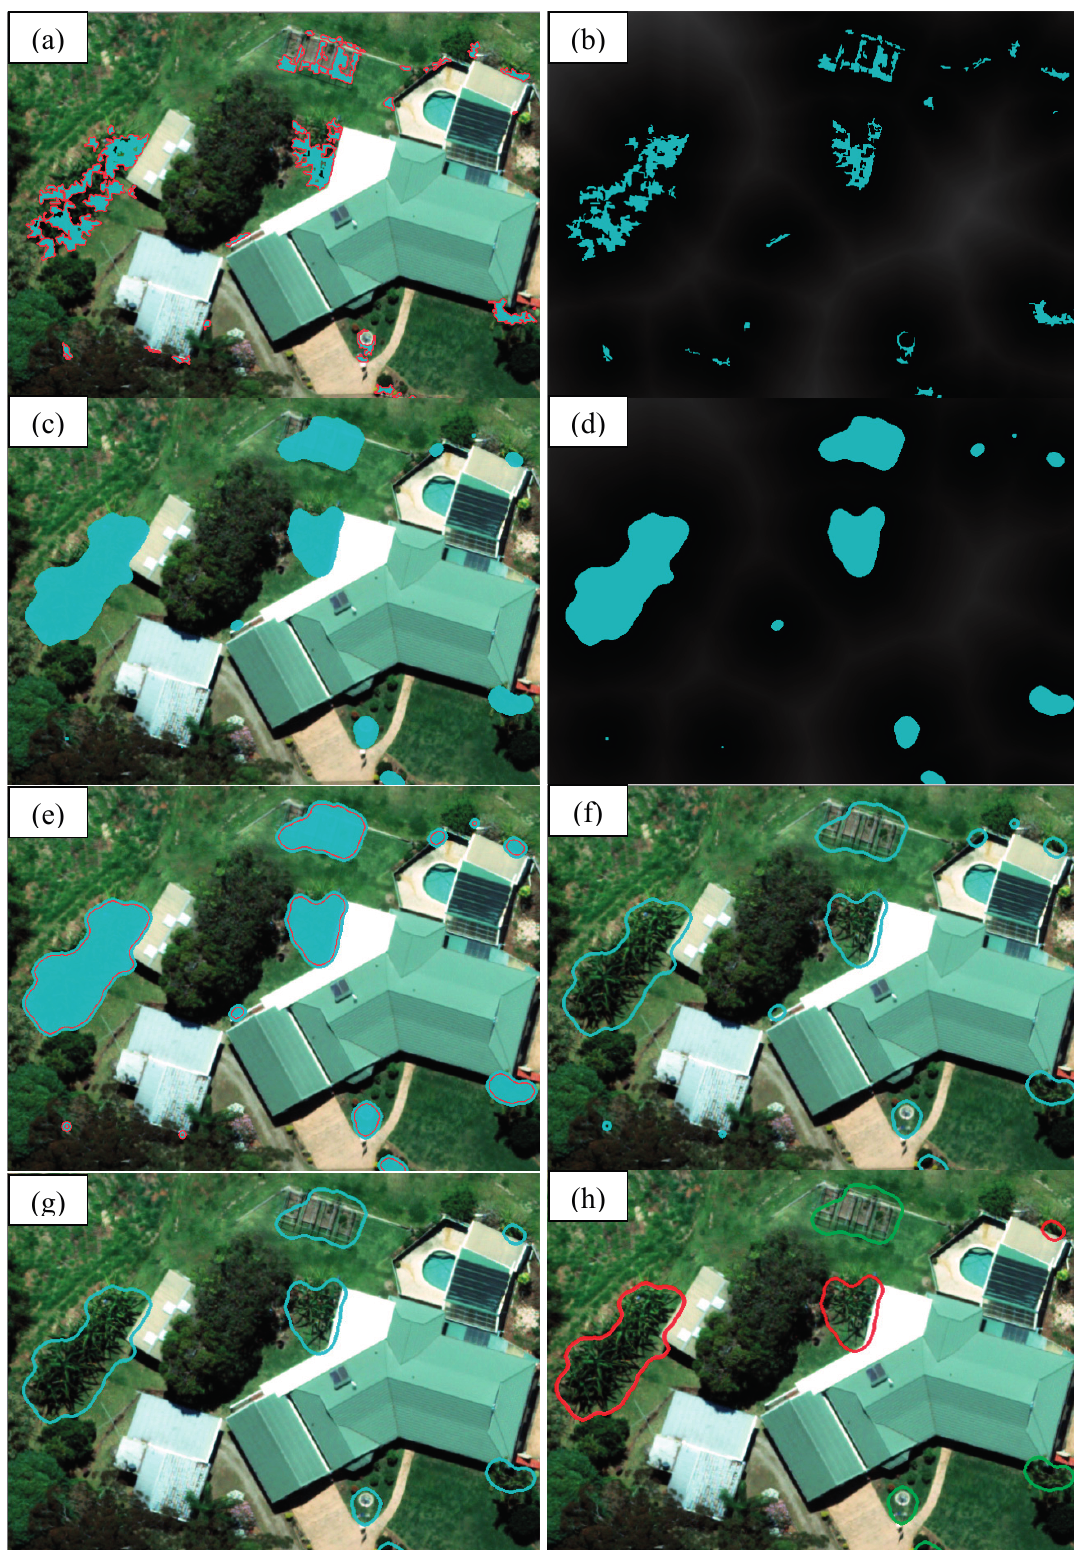
Figure 8. ( a ) Banana plant classification result; ( b ) distance map; ( c ) smoothed banana plant objects; d ) distance map; ( e ) buffer around the smoothed banana plant objects; ( f , g ) remaining buffers, and ( h ) final classification result after the visual assessment (red outlines = banana plants, green outlines = excluded false positives). Location: 153°02 ′ 00 ″ E, 26°41 ′ 45 ″